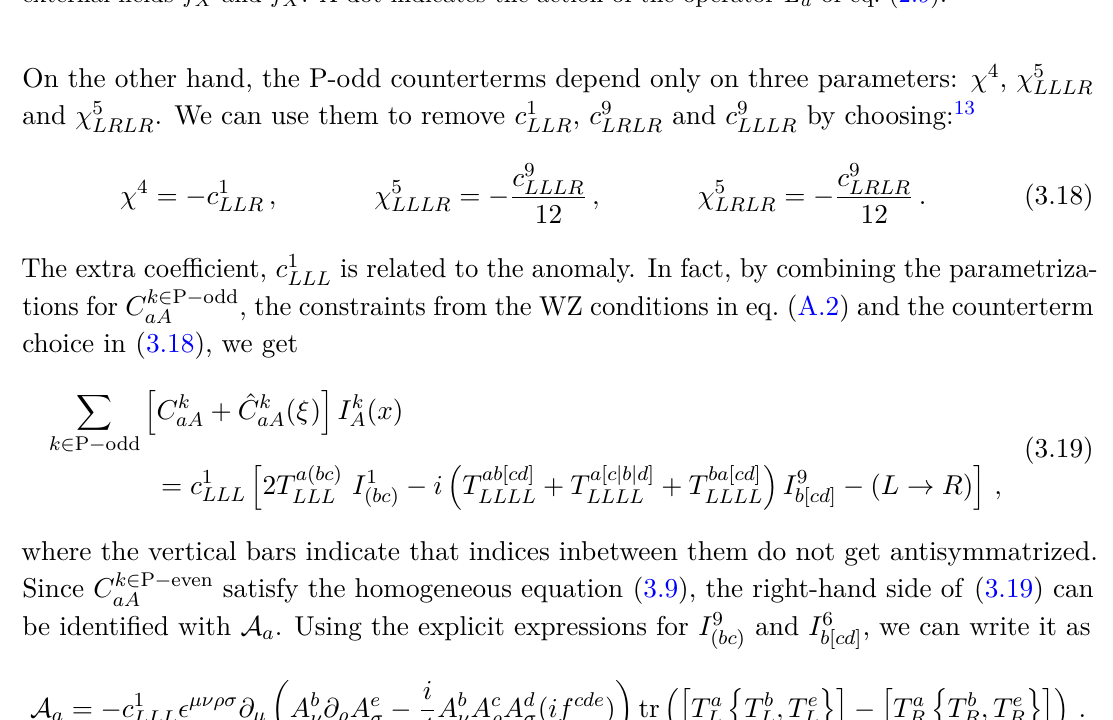
Figure 1 . Diagrams contributing to C 12 external fields ¯ f X and f X . A dot indicates the action of the operator L a of eq.